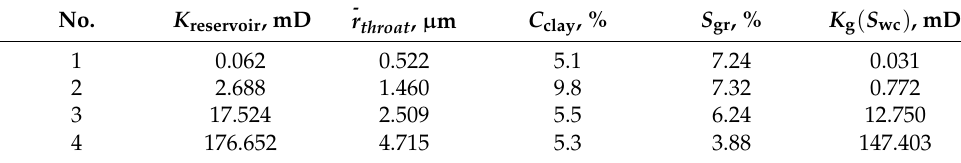
Figure 5. Gas phase relative and effective permeability curve. Table 4. Gas phase characteristic value and rock sample property